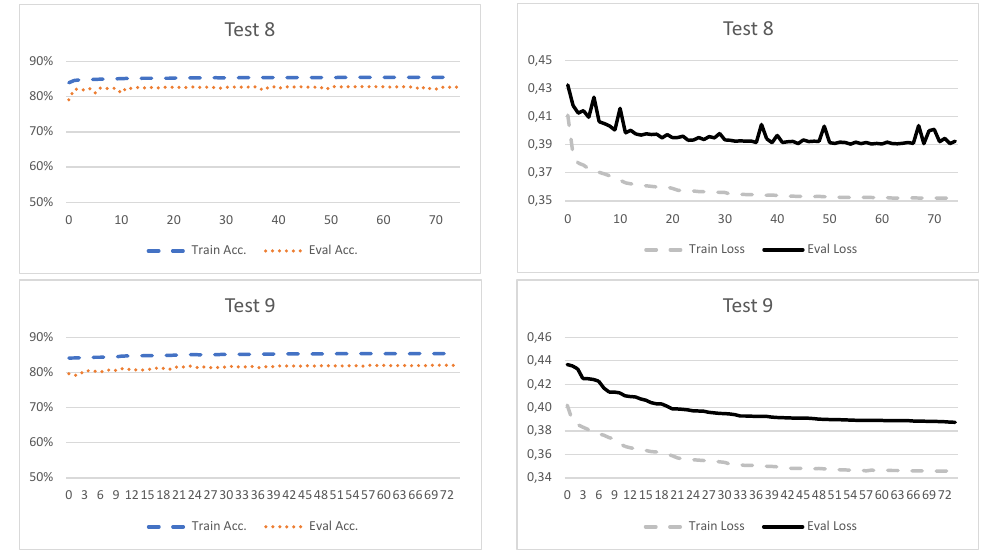
Figure 4: Accuracy and loss for training and evaluation of a forest point cloud with and without alignment